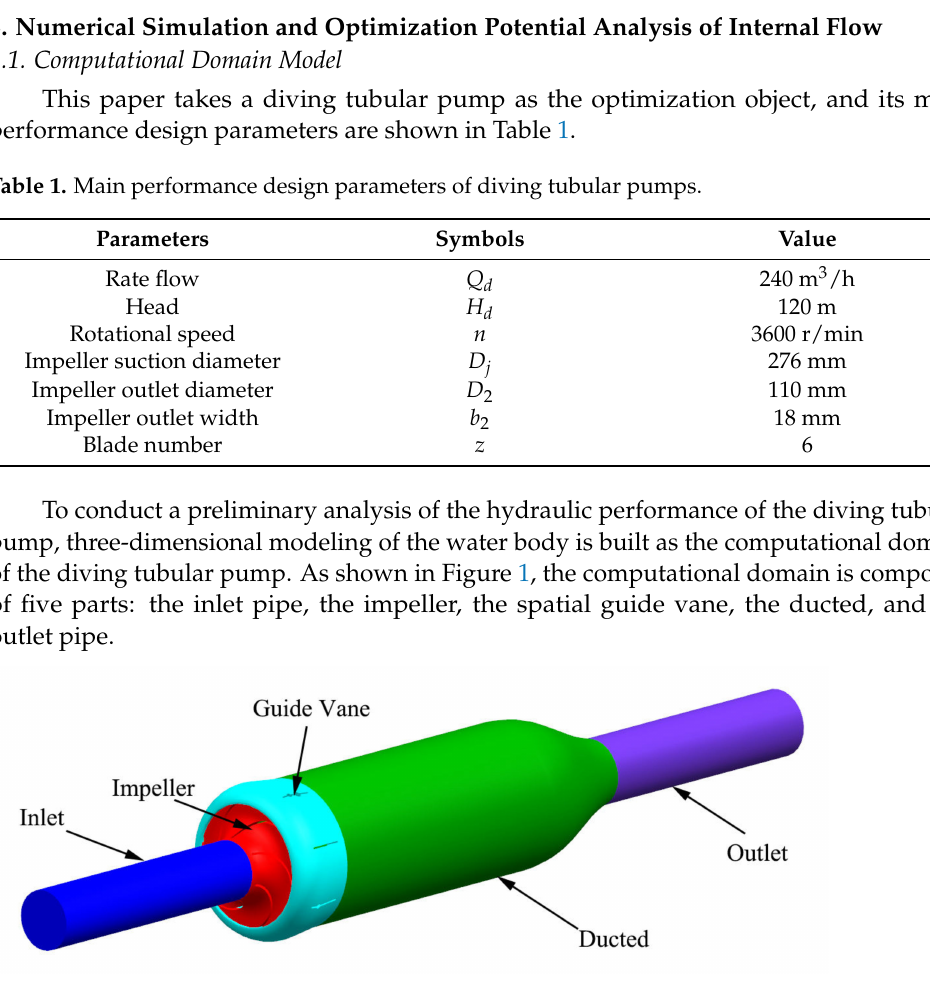
Figure 1. Three-dimensional model of a diving tubular pump computational